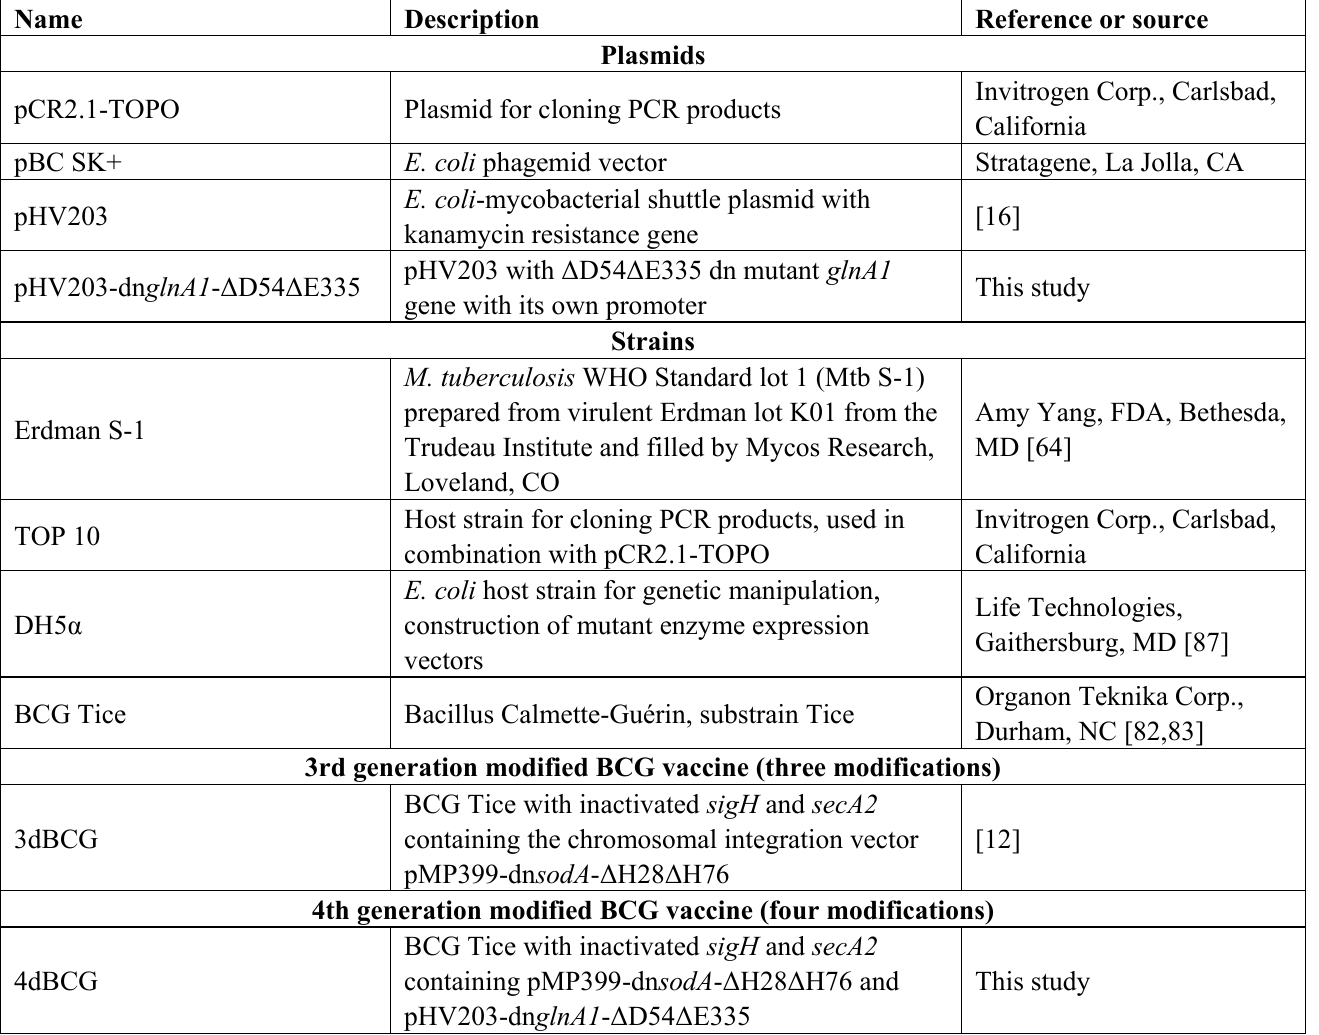
Table 1. Tools for genetic manipulations and bacterial